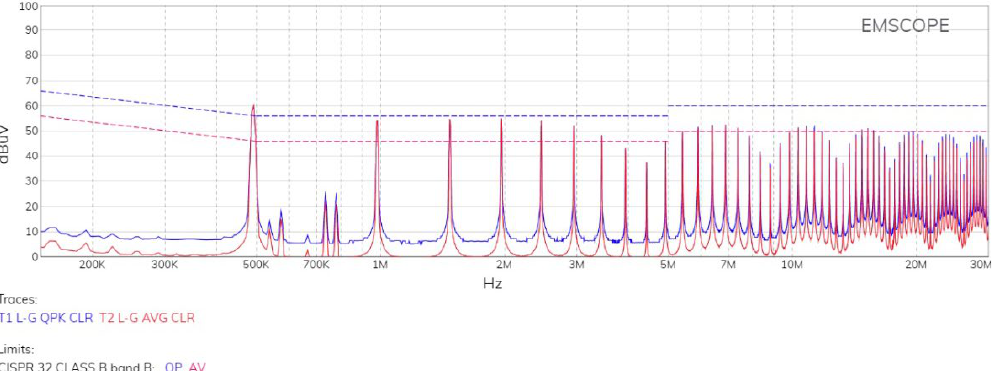
Figure 14. CE measurement at the positive terminal (‘+’) of the Boost converter using the quasi-peak (QPK, blue) and average (AVG, red) detectors. Amplitude units are in dBµV, and Frequency units are in Hz.